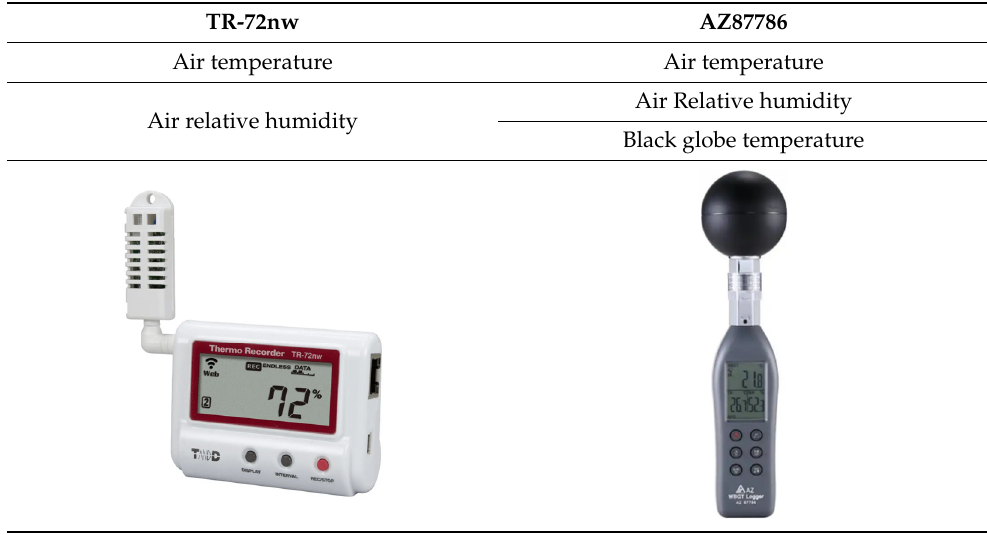
Table 5. Information concerning the measurement instruments.